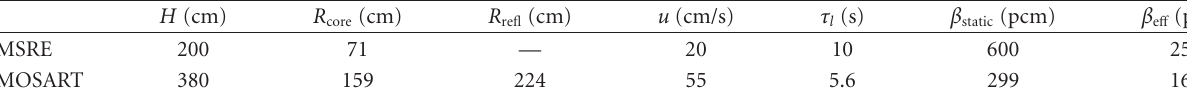
Table 1: Geometrical data for the systems analyzed.